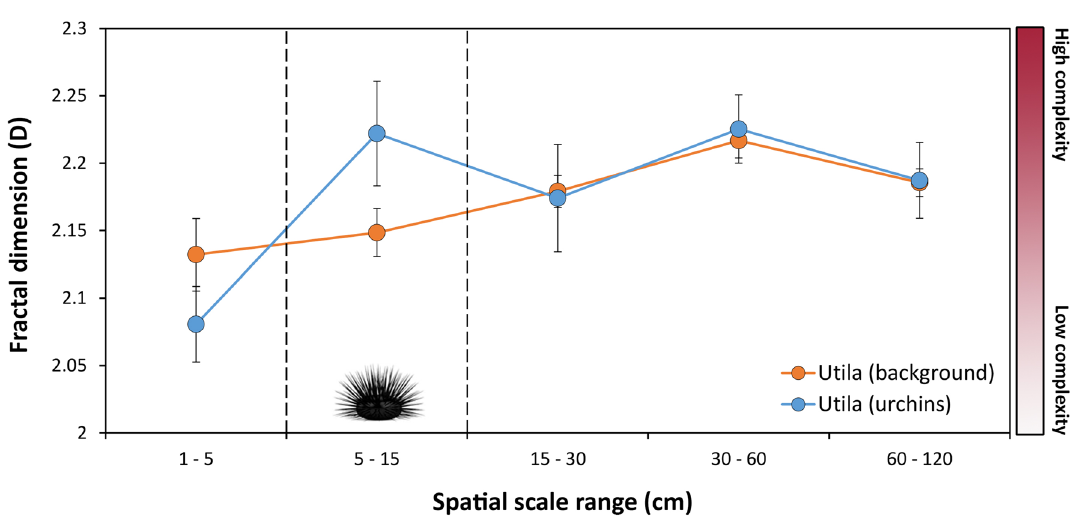
Figure 4. Complexity signatures of reef areas devoid of D. antillarum (orange, n = 35), and areas inhabited by D. antillarum (blue, n = 5). Data shown in the main panel are mean ± 1SE fractal dimension (D), a measure of structural complexity within defined spatial resolutions, shown at: 1–5 cm, 5–15 cm, 15–30 cm, 30–60 cm and 60–120 cm, with 5–15 cm representing the size range of ecological significance to D. antillarum as predation refugia. D ranges from 2 to 3 and higher values are associated with greater structural complexity. Error bars represent ± 1SE from the